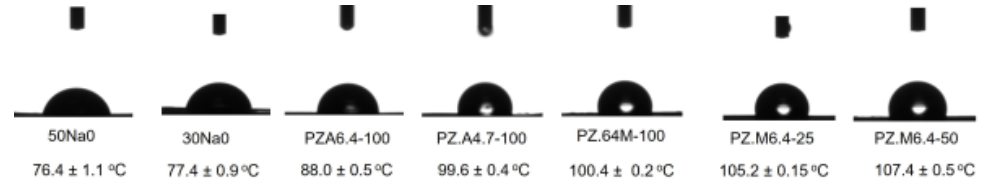
Figure 10. ( a ) BSA uptake as a function of BSA concentration in zeolite at various pH values, ( b ) BSA adsorption efficiency of hydrogel films. 3.3.2. BSA Adsorption in Pectin–Zeolite Hydrogel Films The efficiency of BSA adsorption in selected pectin–zeolite films is given in Table 1 and Figure 10b. Both at pH 6.4 and 4.7, BSA molecules are successfully adsorbed in pectin– zeolite matrices, as implied by FT-IR, SEM, zeta potential, and rheology analyses. BSA uptake at pH 4.3 is low. Two-way ANOVA and Tukey’s test to assess the effect of pH and BSA concentration on BSA uptake are conducted. We show that BSA adsorption efficiency of pectin–zeolite hydrogel films significantly decreases with decreasing pH of the loading medium ( p < 0.0001). The effect of BSA loading concentration is also found to be signifi- cant, with a p -value = 0.027. A6.4-100 and A6.4-50 adsorb 88 mg BSA/g film and 37 mg